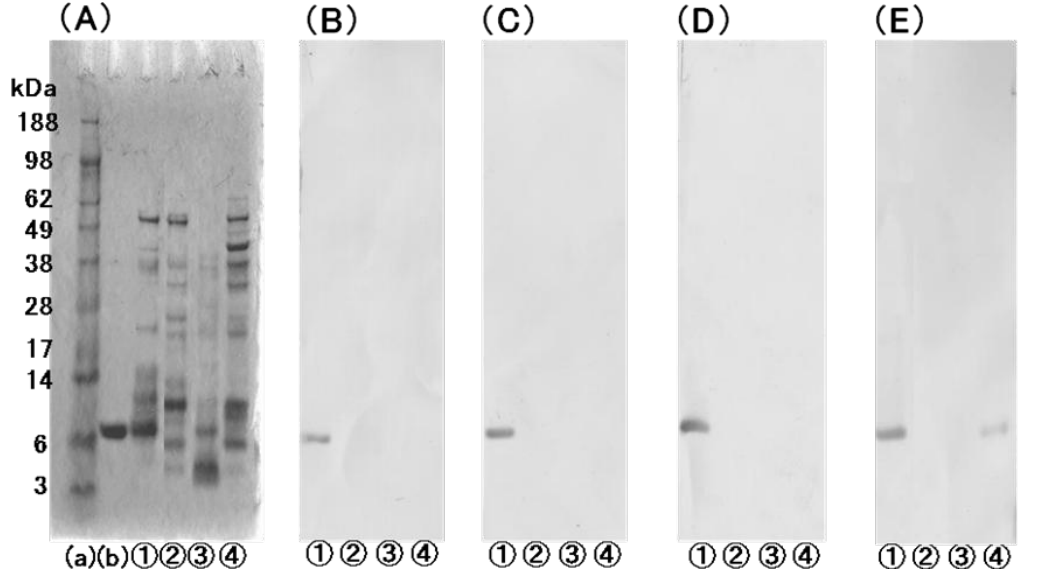
Figure 3. Cross reactivity of anti-bLTP monoclonal antibodies with other cereal grain LTPs. ( A ) SDS-PAGE pattern of molecular mass markers (a), 2 µg of bLTP (b), and 8 µg of PBS-extracted proteins from barley ① , wheat ② , adlay ③ , and rye ④ . ( B – E ) Western blotting pattern of PBS-extracted barley proteins (8 µg) with various established anti-bLTP monoclonal antibodies (mAbs). ( B ), 5-4; ( C ), 10-1; ( D ), 10-4; ( E ) 12-3.